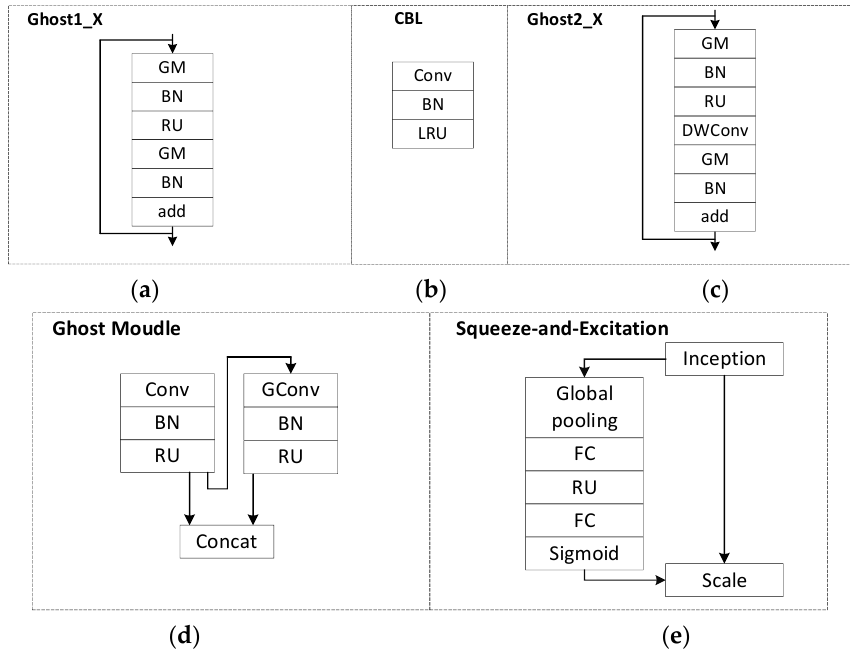
Figure 3. Internal structure diagram of each module in the backbone network. ( a ) The internal structure of Ghost1 _ X module in the backbone network; ( b ) the internal structure of CBL module in the backbone network; ( c ) the internal structure of Ghost2 _ X module in the backbone network; ( d ) the internal structure of Ghost module in the backbone network; ( e ) The internal structure of SE module in the backbone